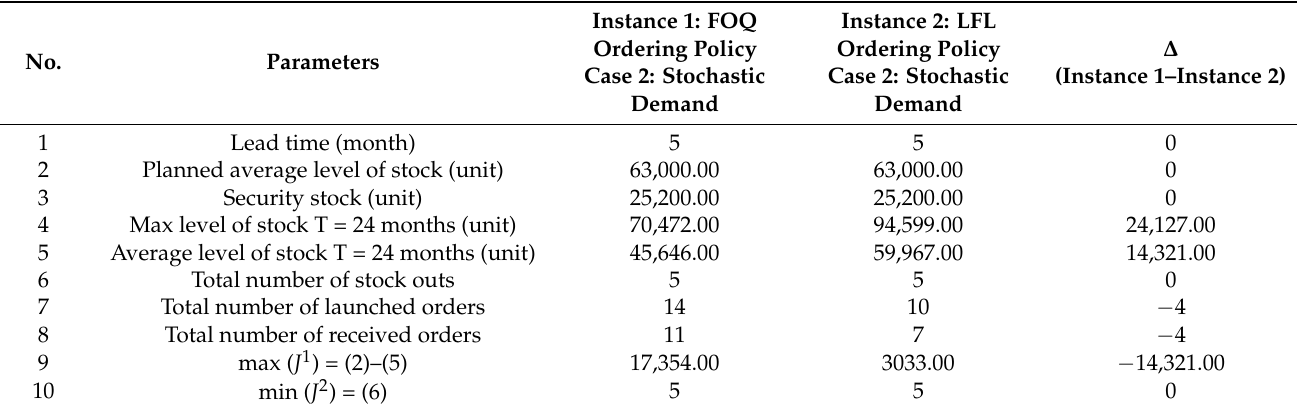
Table 5. Comparison of numerical results for Instance 1 and Instance 2 in Case